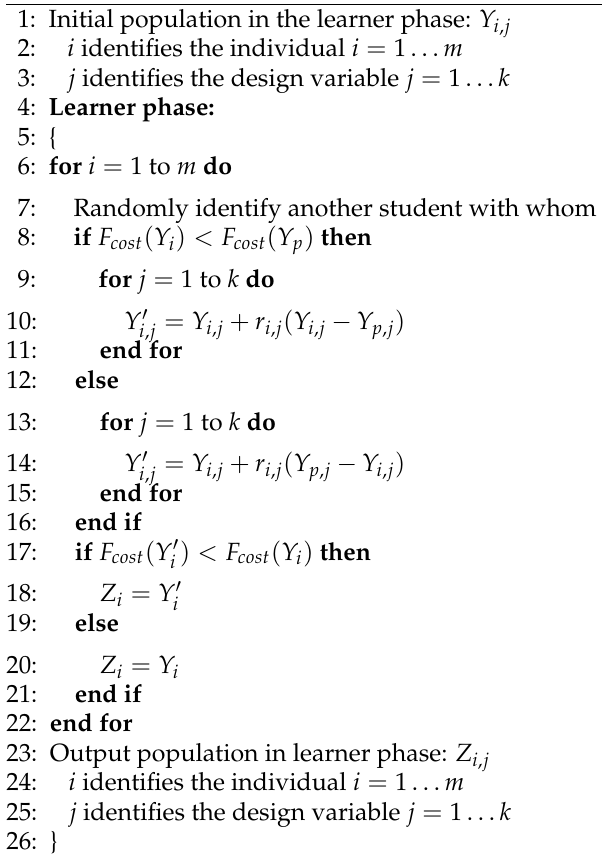
Algorithm 2 Learner phase of TLBO